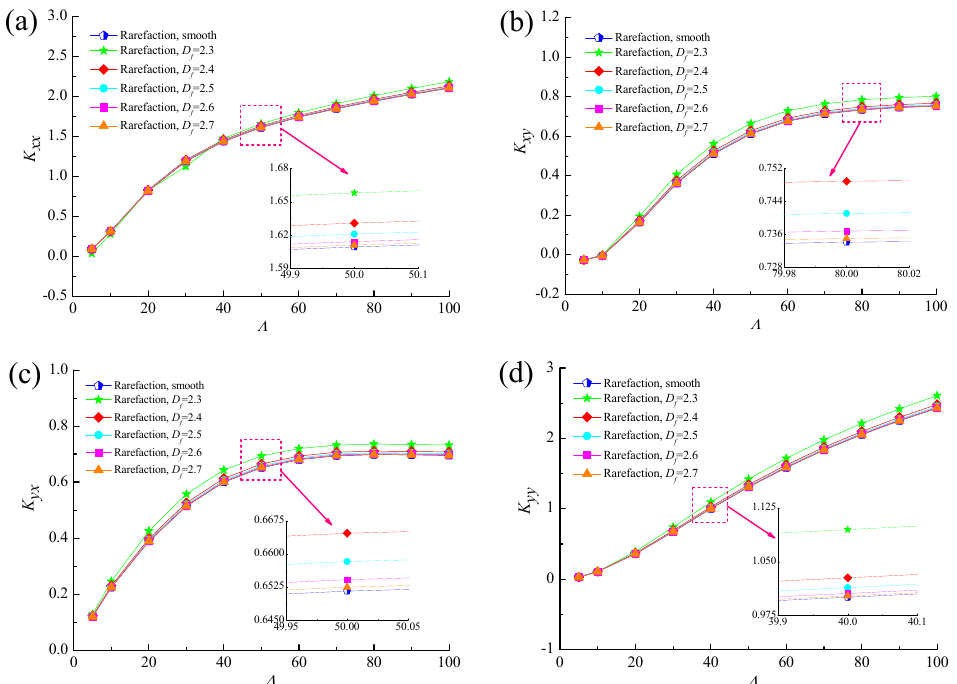
Figure 16. Effect of bearing number on dynamic stiffness coefficients with different fractal dimensions. ( a ) K xx vs. Λ ; ( b ) K xy vs. Λ ; ( c ) K yx vs. Λ ; ( d ) K yy vs. Λ.